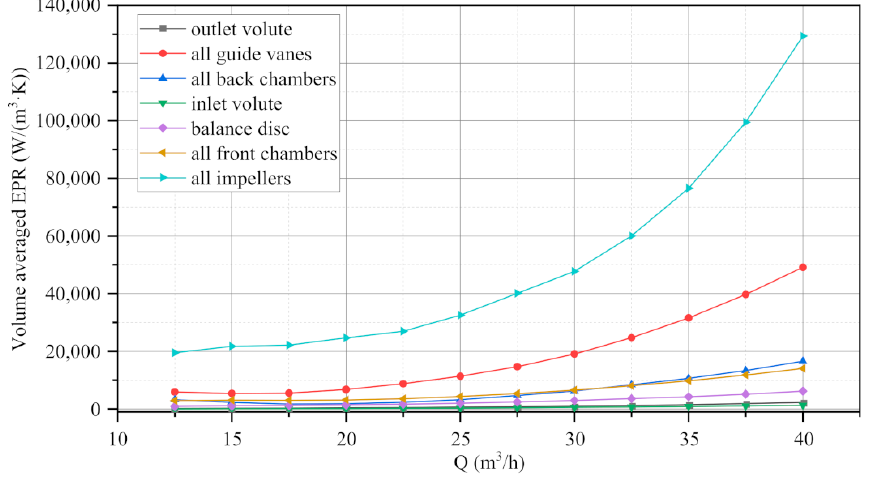
Figure 8. Comparison of energy loss of different components in multi‑stage